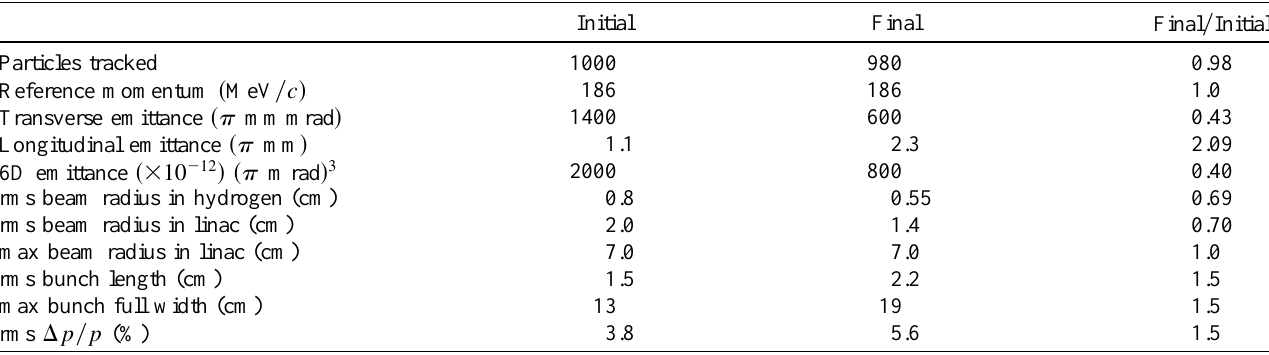
TABLE V. Initial and final beam parameters in a 15 T transverse cooling